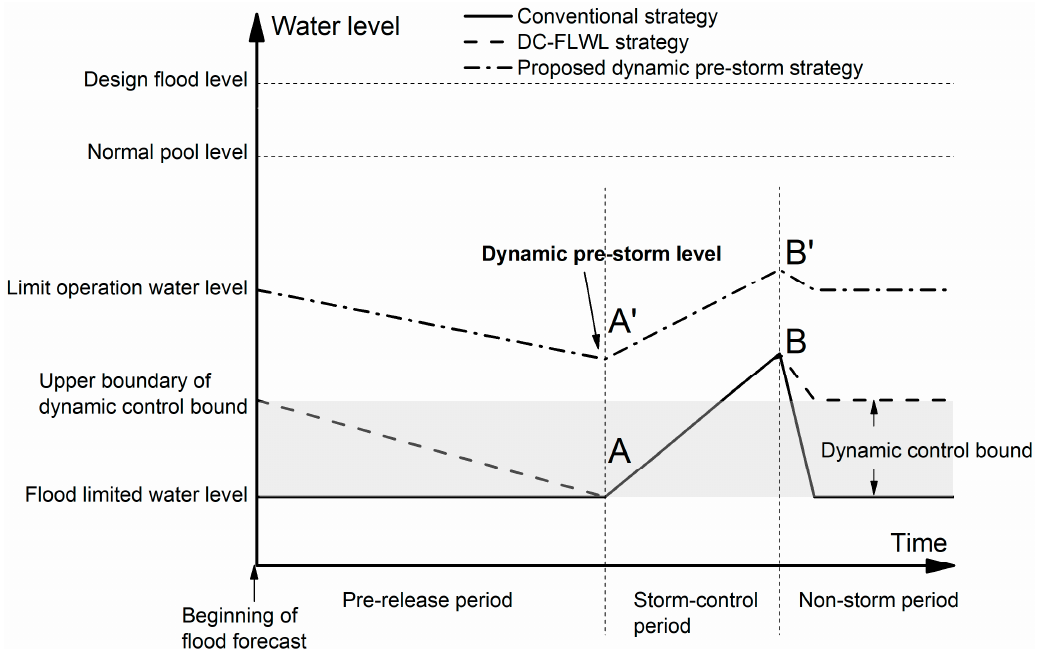
Figure 1. Schematic diagram of reservoir water level operation trajectories under three different flood-control operation strategies.